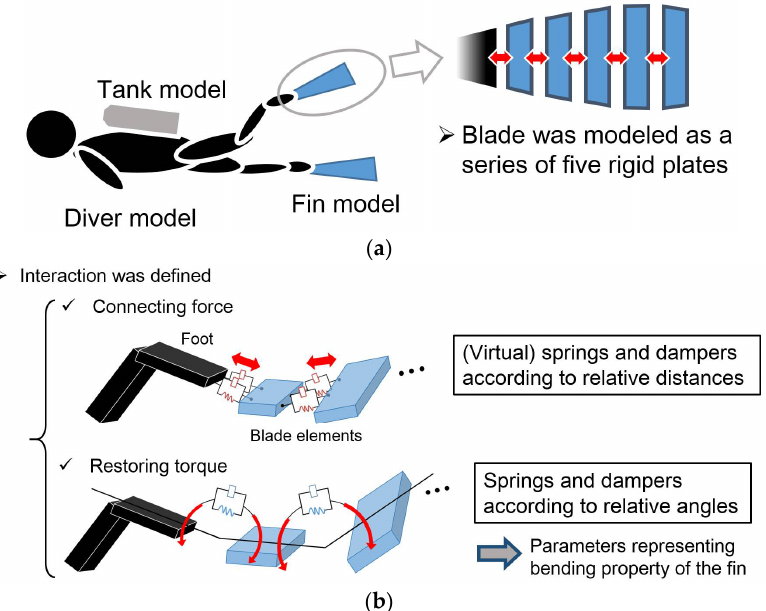
Figure 1. Schematic figure of the simulation model for swimming with diving fins: ( a ) Overall view; ( b ) Detailed representation of the fin